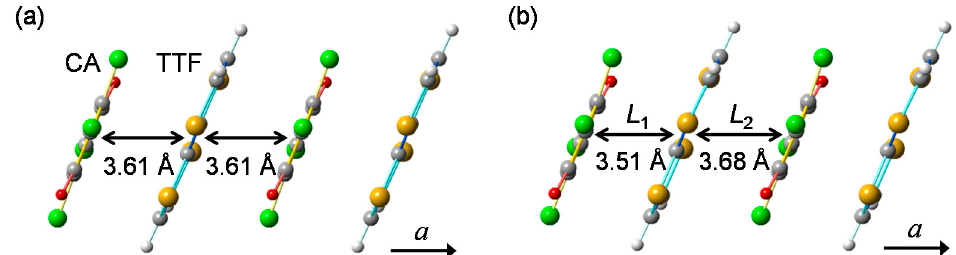
Figure 4. ( a , b ) Molecular arrangements viewed along the direction perpendicular to the stacking axis ( a axis) at ( a ) 90 K (the neutral phase) and ( b ) 40 K (the ionic phase) in TTF-CA [41]. L 1 and L 2 in ( b ) denote the intradimer and interdimer distances, respectively.